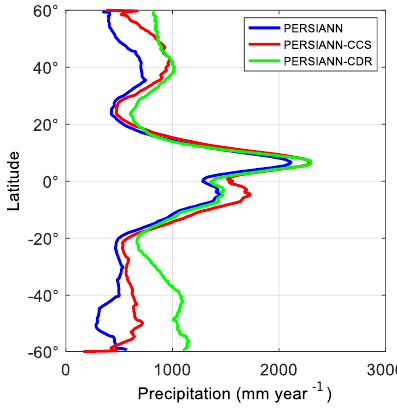
Figure 7. Mean annual zonal precipitation (mmyr − 1 ) for PER- SIANN, PERSIANN-CCS, and PERSIANN-CDR.